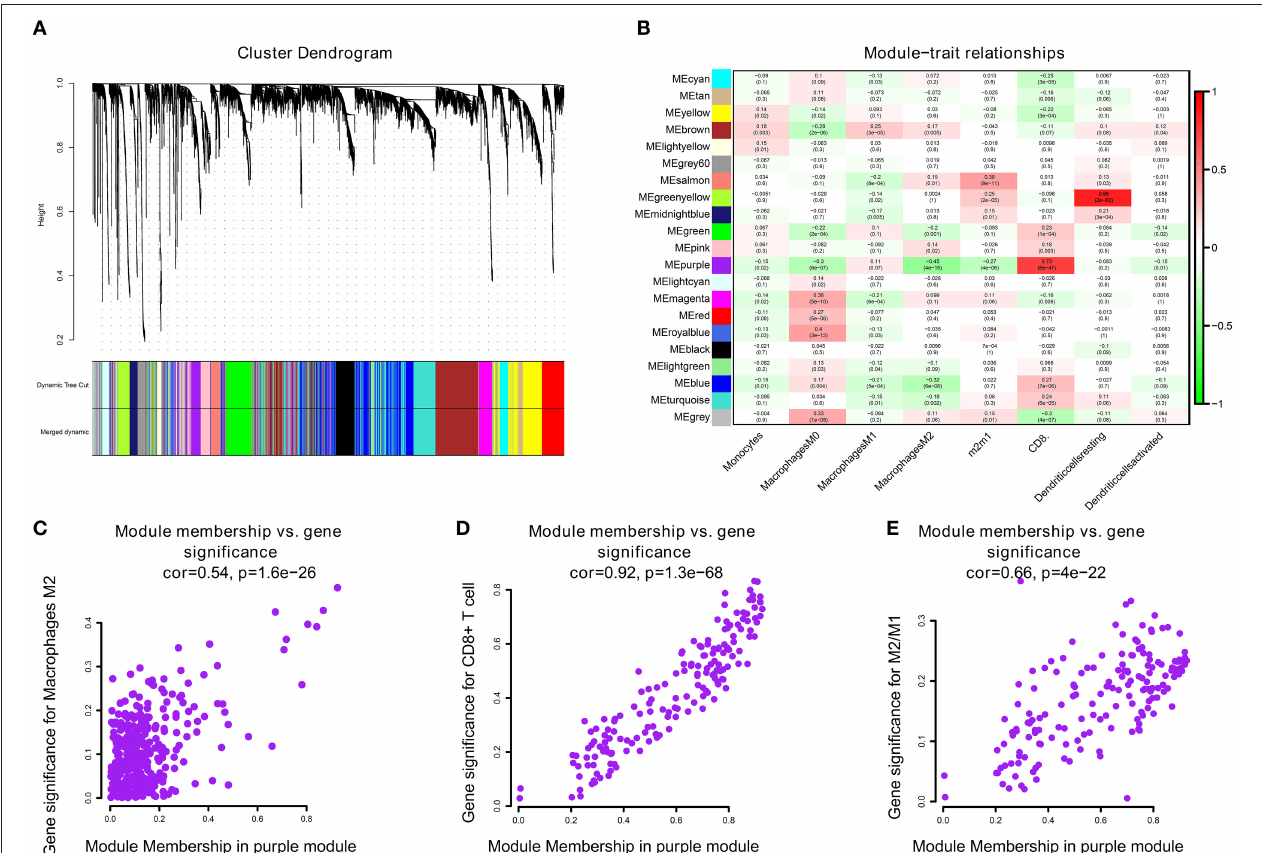
FIGURE 2 | (A) A hierarchical clustering tree was built using the dynamic hybrid cutting method, where each leaf on the tree represents a gene, and each branch represents a co-expression module; 21 co-expression models were generated. (B) The correlation coefficients between each phenotype and co-expression module of TCGA. The purple module had the strongest correlation with M2 macrophage cell proportions in the TCGA–KIRC cohort (Cor = − 0.45; P = 4e − 15 ) and had the strongest correlation with CD8 + T cell proportions in the TCGA–KIRC cohort (Cor = 0.73; P = 6e − 47 ). (C) The relationship between the purple module membership degree and the gene significance of M2 macrophages (cor = 0.54; P = 1.6e − 26). (D) The relationship between the purple module membership degree and the gene significance of CD8 + T Cells (cor = 0.92; P = 1.3e − 68). (E) The relationship between the purple module membership degree and the gene significance of M2/M1 ratio (cor = 0.66; P = 4e −